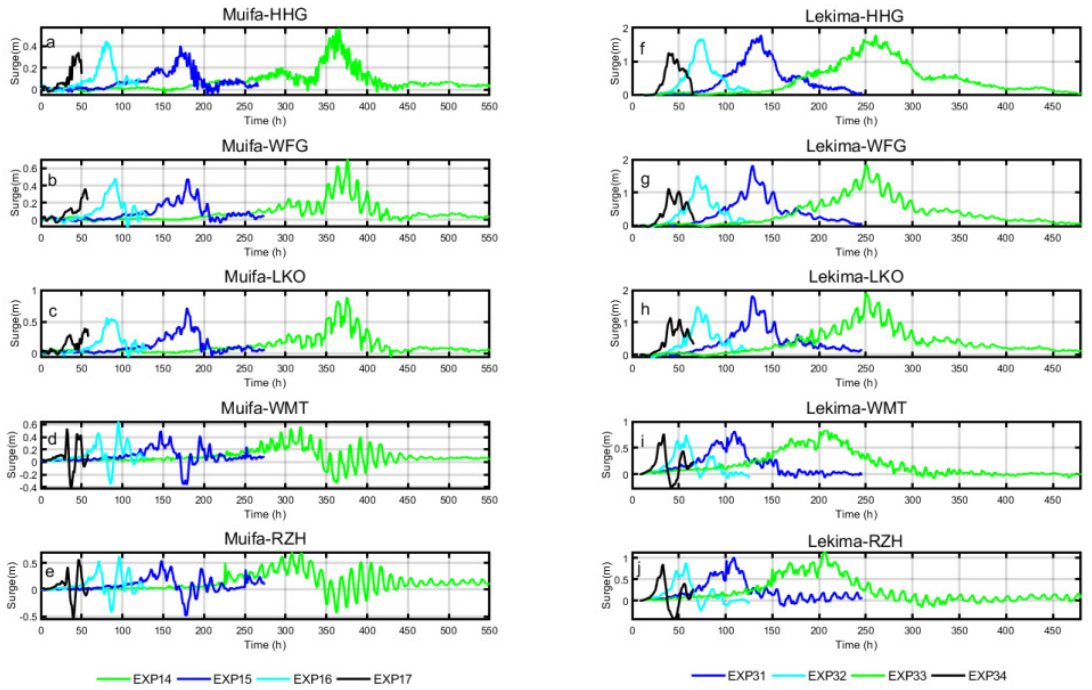
Figure 18. Storm surge associated with the translation speed over time at ( a ) HHG, ( b ) WFG, ( c ) LKO, ( d ) WMT, and ( e ) RZH for Typhoon Muifa and ( f ) HHG, ( g ) WFG, ( h ) LKO, ( i ) WMT, and ( j ) RZH for Typhoon Lekima.